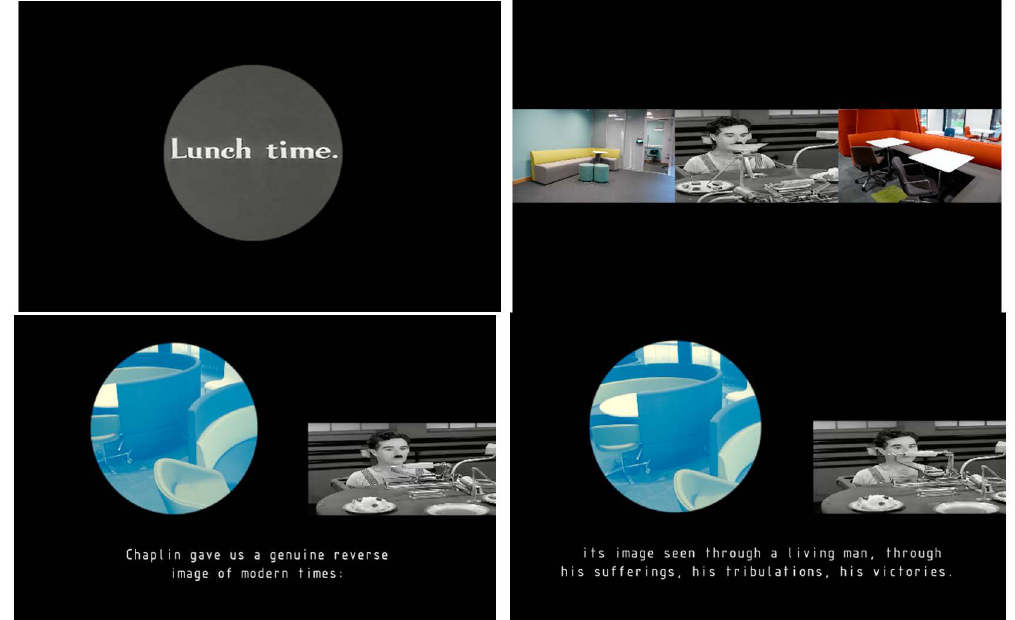
Screen grabs from the short film, The Death and Life of UK Universities (Source: c (cid:13) Igea Troiani and Tonia Carless, 2020). The four screen grabs include ‘lounge learning’ furniture in various UK universities, excerpts of new technologies for lunchtime hands-free work from Modern Times by Charlie Chaplin (1936) and musings by Lefebvre on Modern Times from Critique of Everyday Life (1991).